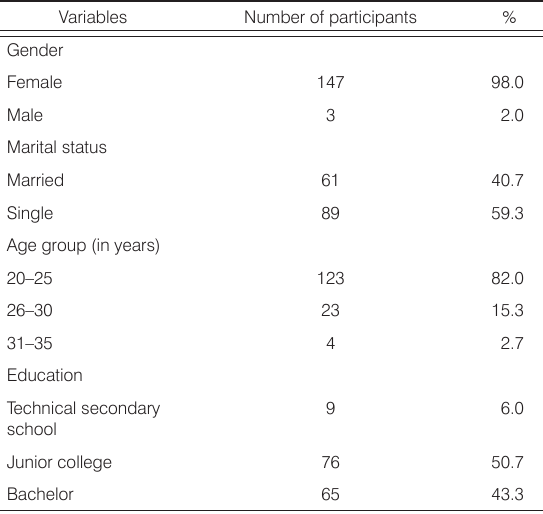
Table 1. Demographic characteristics of the